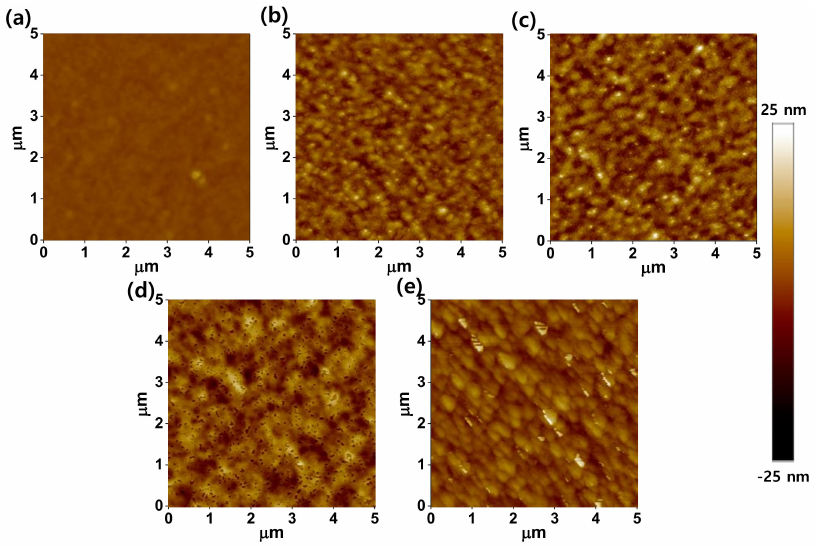
Figure 3. AFM topographic images: ( a ) P3HT films processed without additive, and with ( b ) ODT, ( c ) DPE, ( d ) CN, and ( e ) DIO. The films were thermally annealed at 120 ◦ C for 30